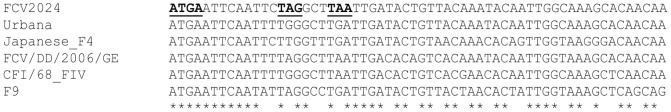
Comparison of the 5′ terminal VP2-coding sequences of different FCV isolates.Comparison of the cDNA sequences of the ORF3 5′ region for different FCV isolates. In the FCV 2024 sequence, the start/stop site and the two downstream stop codons in the ORF2 frame are highlighted. Residues conserved in all sequences are marked by asterisks.